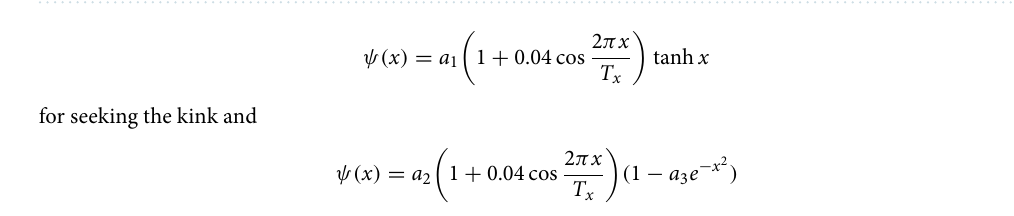
Figure 3. Profiles of dark solitons lie in ( a ) the semi-infinite gap, ( c , f ) the first gap, and ( d ) the first band, for 0.1 with different nonlinear interaction strength. ( b , e ) Residual diagram of the NCG method versus the q = number of iterations for the dark solitons shown in ( a ) and ( d ), respectively. Shaded regions represent lattice sites, i.e., regions of low potential values V ( x